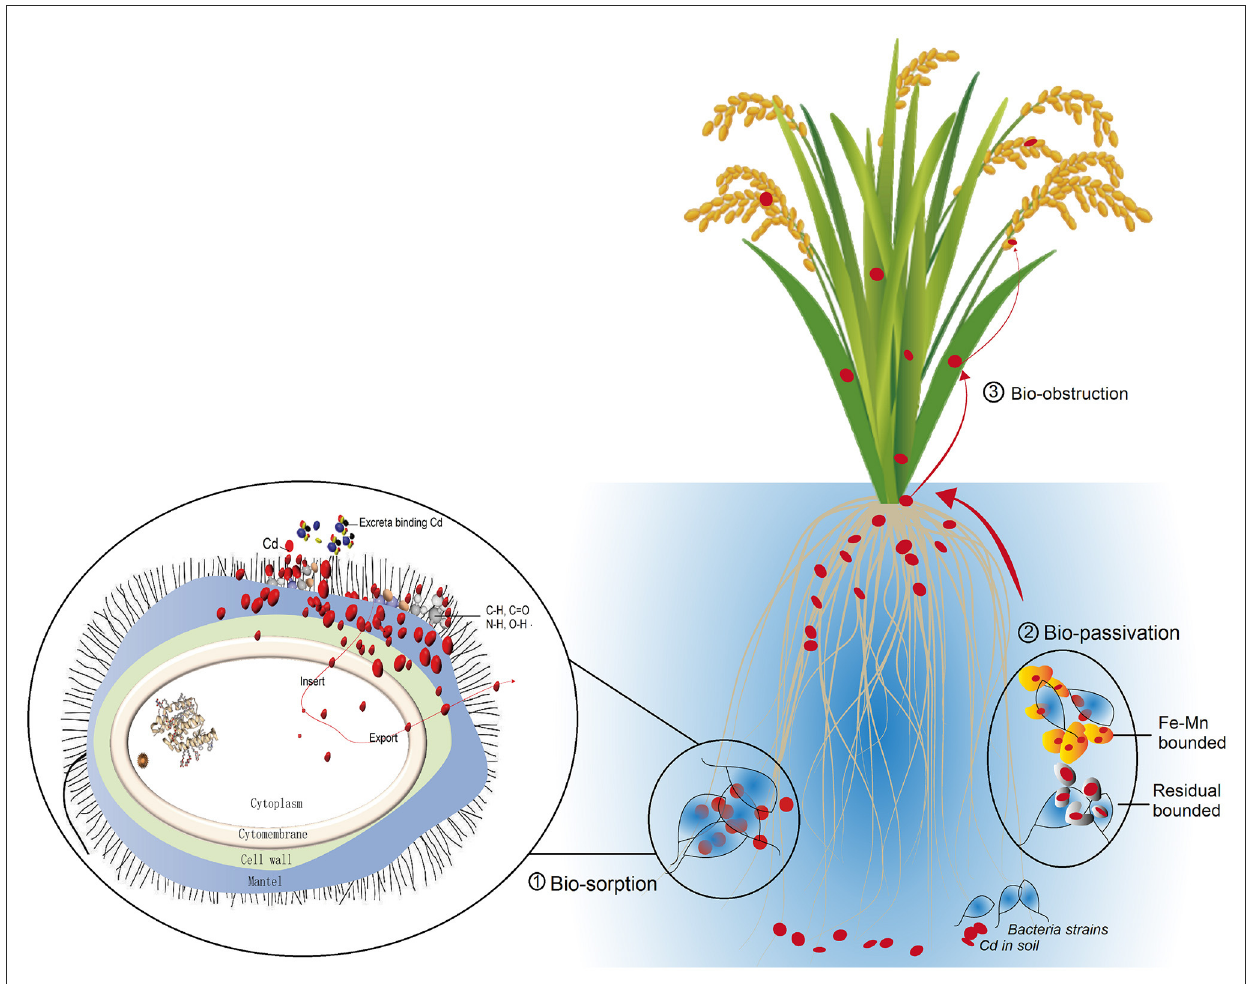
FIGURE6 Conceptual graph summarizes the Cd dispose mechanism of the two microbial strains, including biosorption mainly via cell mantel and cell wall (Bio-sorption), bio-passivation of soil Cd as Fe–Mn combined form (Bio-passivation), and the bio-obstruction (Bio-obstruction) achieved by transmission from root to straw and